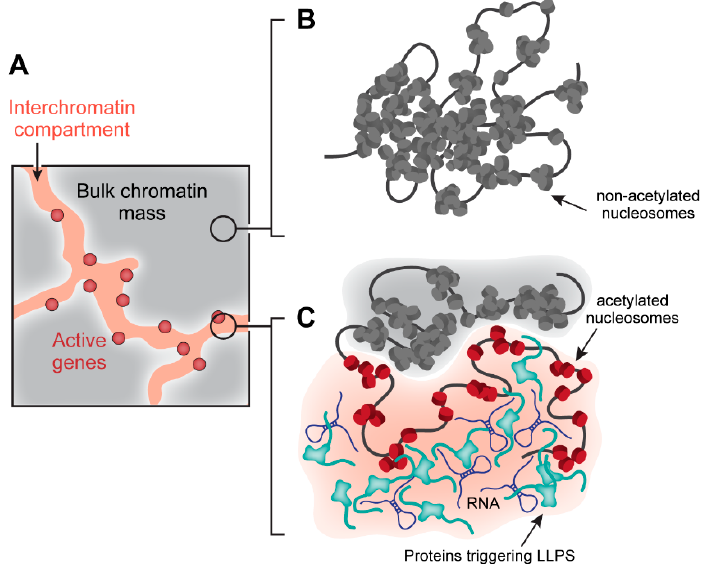
Figure 1. Interchromatin compartment (IC) and bulk chromatin mass form separate phases demarcated with actively transcribed genes lining channels of the IC ( A ). Phase separation is driven by interactions between non-acetylated nucleosomes (grey) in repressed chromatin ( B ) and weak multivalent interactions between IDR-containing proteins (light blue), RNA, and acetylated chromatin (red) in IC channels ( C ).